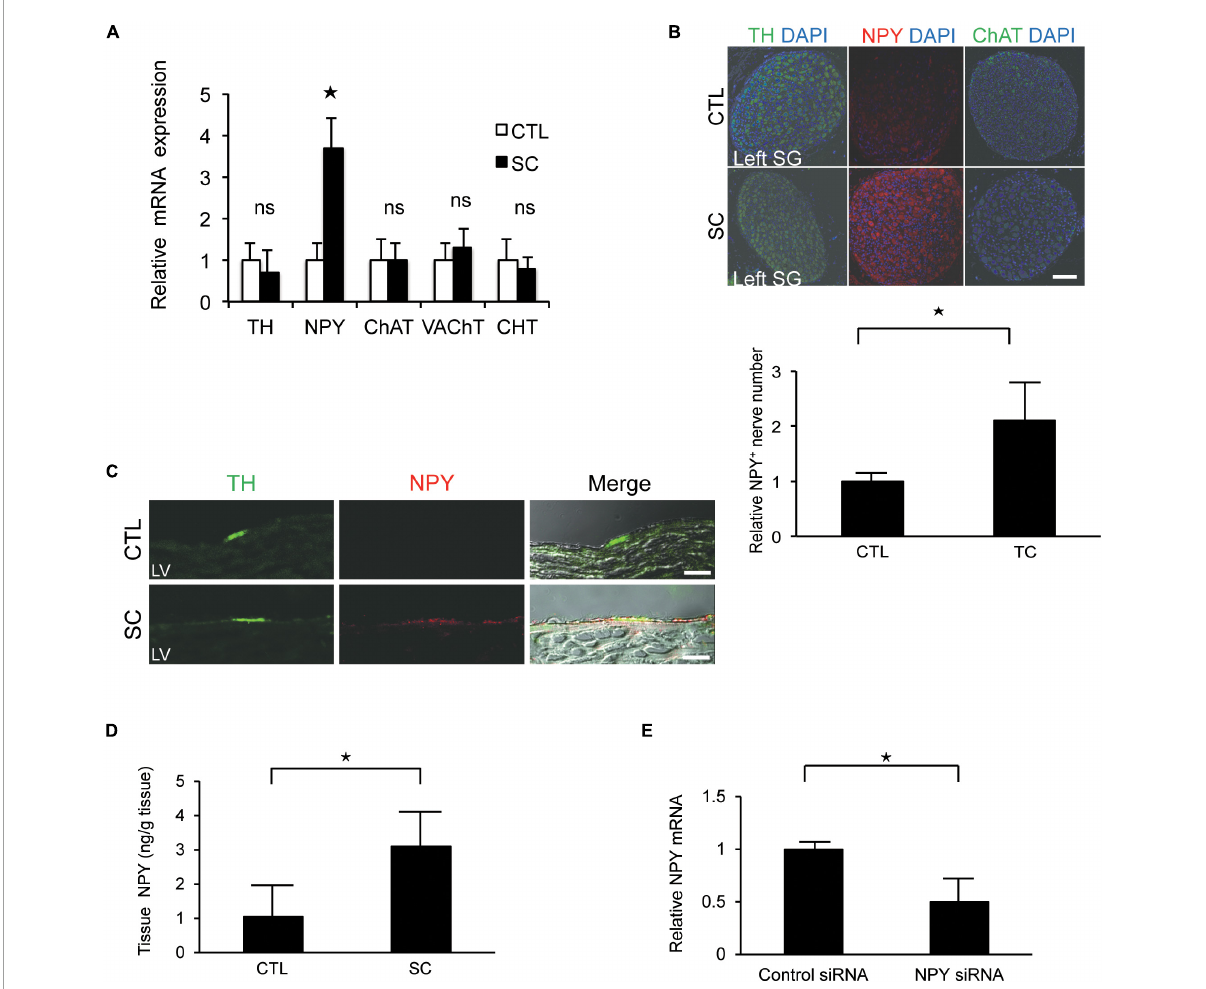
FIGURE3 Upregulation of neuropeptide Y (NPY) expression in the left stellate ganglion (SG) and cardiac sympathetic nerves. (A) mRNA expression of various neuronal markers in the left SG in the control (CTL) and stress cardiomyopathy (SC) groups. SGs in SC model were collected 2 h after the commencement of epilepsy. NPY expression was significantly increased in the SC model, whereas there was no increase in the expression of the choline transporter (CHT), choline acetyltransferase (ChAT), vesicular acetylcholine transporter (VAchT), or tyrosine hydroxylase (TH; n = 5). (B,C) Triple-immunohistochemistry staining of the left SG and left ventricle (LV) for TH (green), NPY (red), and 4 (cid:48) ,6 (cid:48) -diamidino-2-phenylindole (DAPI; nuclei; blue). NPY upregulation was observed in the SG and cardiac sympathetic nerve of the LV in the SC model. Scale bars: 50 µ m (B) and 100 µ m (C) . (D) NPY content of the apical part of the LV in control and SC rats ( n = 6). (E) Expression level of NPY mRNA significantly reduced following the injection of NPY siRNA into left SG compared to control siRNA ( n = 6). Where appropriate, data are provided as the mean ± SD. * P < 0.05 relative to the